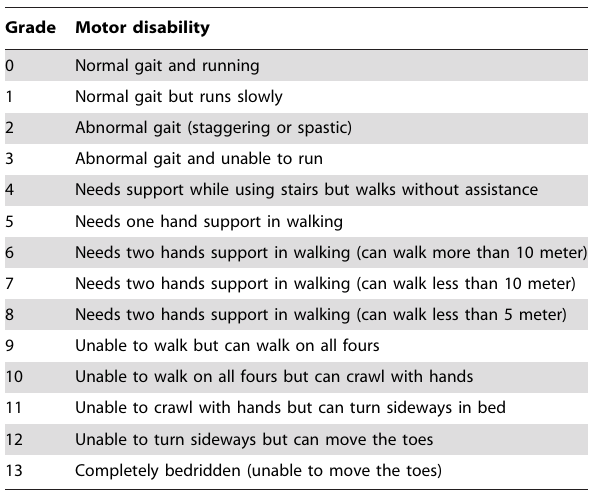
Table 1. Motor disability grading for